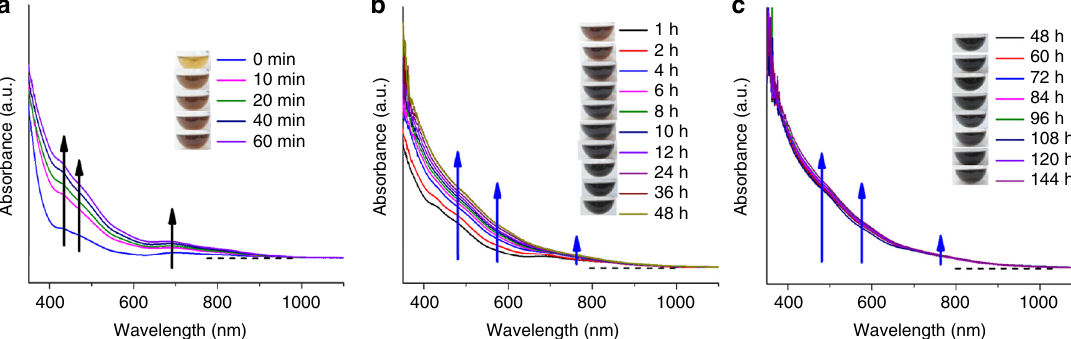
Fig. 2 Monitoring size growth by ultraviolet-visible absorption spectroscopy. Time − course ultraviolet-visible absorption spectra of a pre − growth, b size growth, and c size − focusing stages from [Au 25 (SR) 18 ] − to [Au 44 (SR) 26 ] 2 − . The insets show digital photos of reaction mixture taken at varied reaction times. The black arrows in a are visual guides for the absorption features of [Au 25 (SR) 18 ] − , while the blue arrows in b , c are visual guides for the